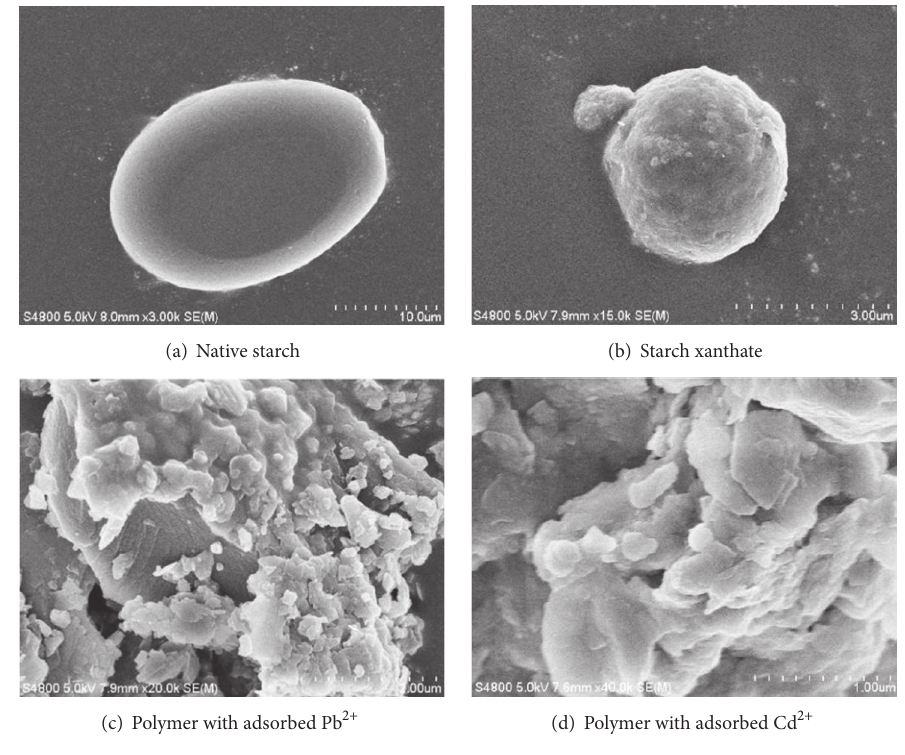
Figure 8: Scanning electron micrographs.